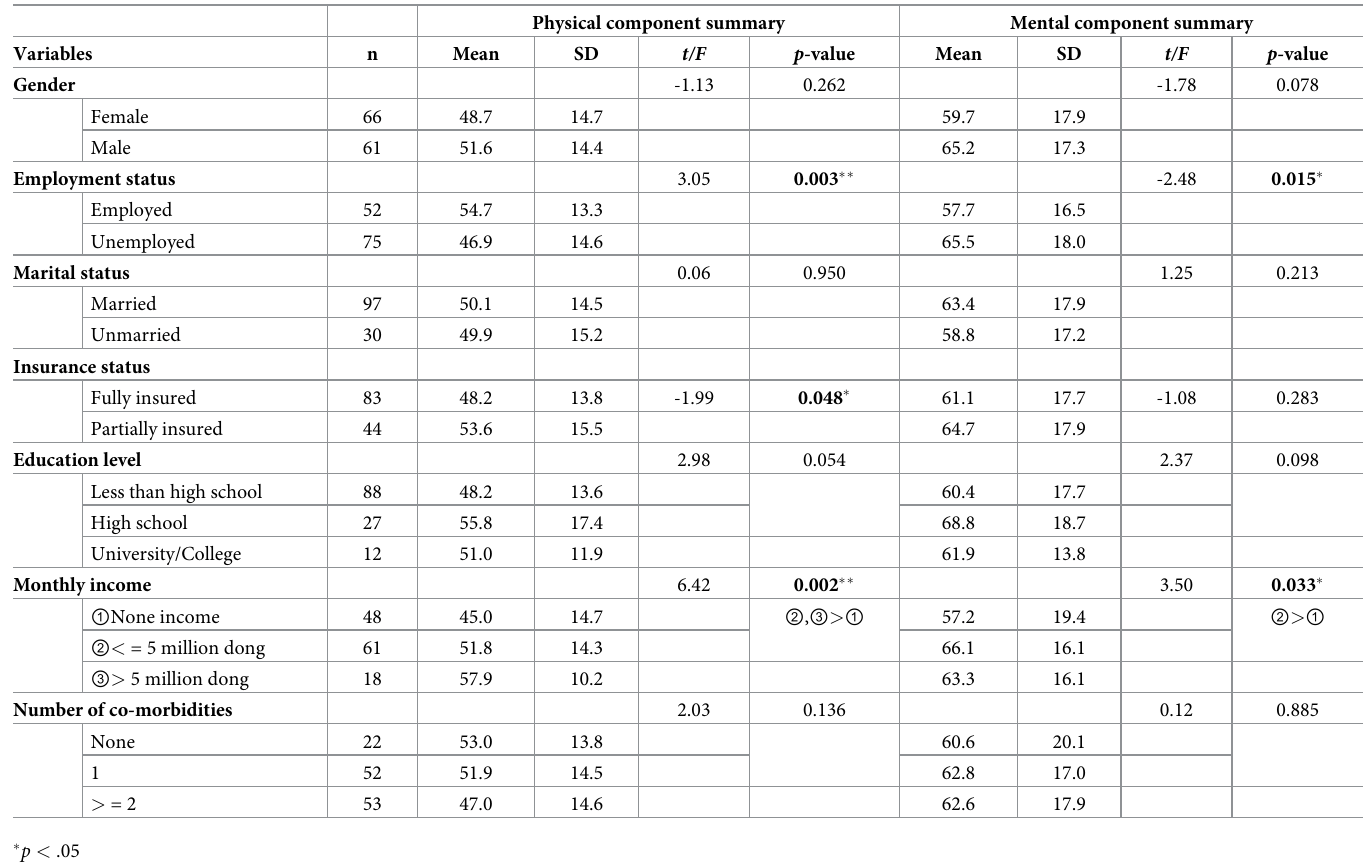
Table 3. Demographics and medical variables by PCS and MCS (n = 127).